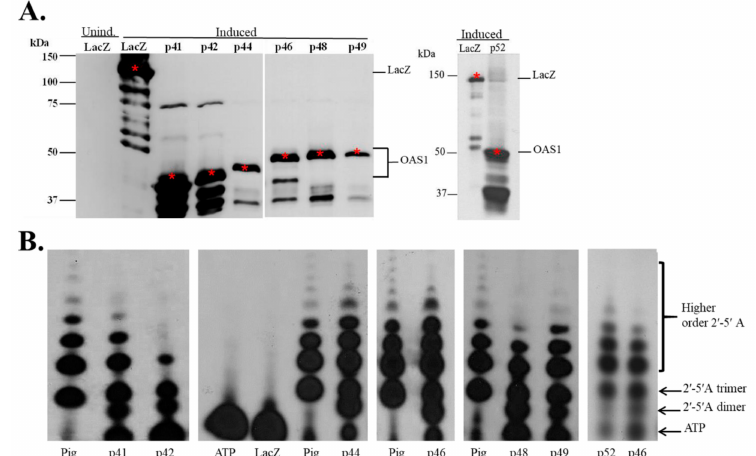
Figure 2. Bacterial expression of hOAS1 isoform proteins and analysis of their ability to produce 2-5A. ( A ) Seven hOAS1 isoform fusion proteins and LacZ protein were expressed individually in bacteria. After isopropyl β - d -1-thiogalacto-pyranoside (IPTG) (1 mM) induction, bacteria were lysed and proteins in the crude bacterial lysates were separated by 10% sodium dodecyl sulfate-polyacrylamide gel electrophoresis (SDS-PAGE), transferred to a nitrocellulose membrane and immunoblotted with anti-V5 antibody. All of the OAS1 isoforms except for p52 were run on the same gel. A lysate from uninduced bacteria transformed with a plasmid containing the LacZ gene was used as a negative control. The full-length proteins are indicated by a red asterisk. OAS1 degradation bands were detected on the gel below the full-length proteins. ( B ) After protein purification on a Talon metal a ffi nity column, each human OAS1 isoform (22 µ L) was incubated with α 32 P-adenosine triphosphate (ATP) and poly(I:C) for 18 h at 30 ◦ C. LacZ protein plus α 32 P-ATP (Lane 5) and α 32 P-ATP alone (no protein) (Lane 4) were used as negative controls. Purified Escherichia coli ( E. coli )-expressed pig OAS1 (0.5 µ g) was used as a positive control. Two µ L of each reaction were electrophoresed on a 20% polyacrylamide / 8M urea denaturing gel and radiolabeled 2-5A was visualized by autoradiography. Separate gels used to analyze the 2-5A are indicated by